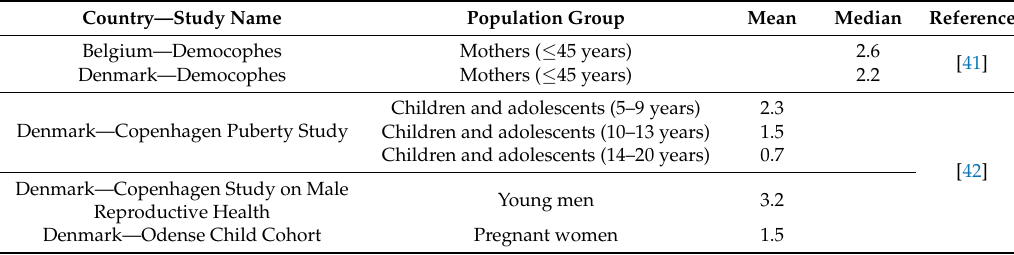
Table 1. Urinary bisphenol A (BPA)-Glu levels from European human biomonitoring